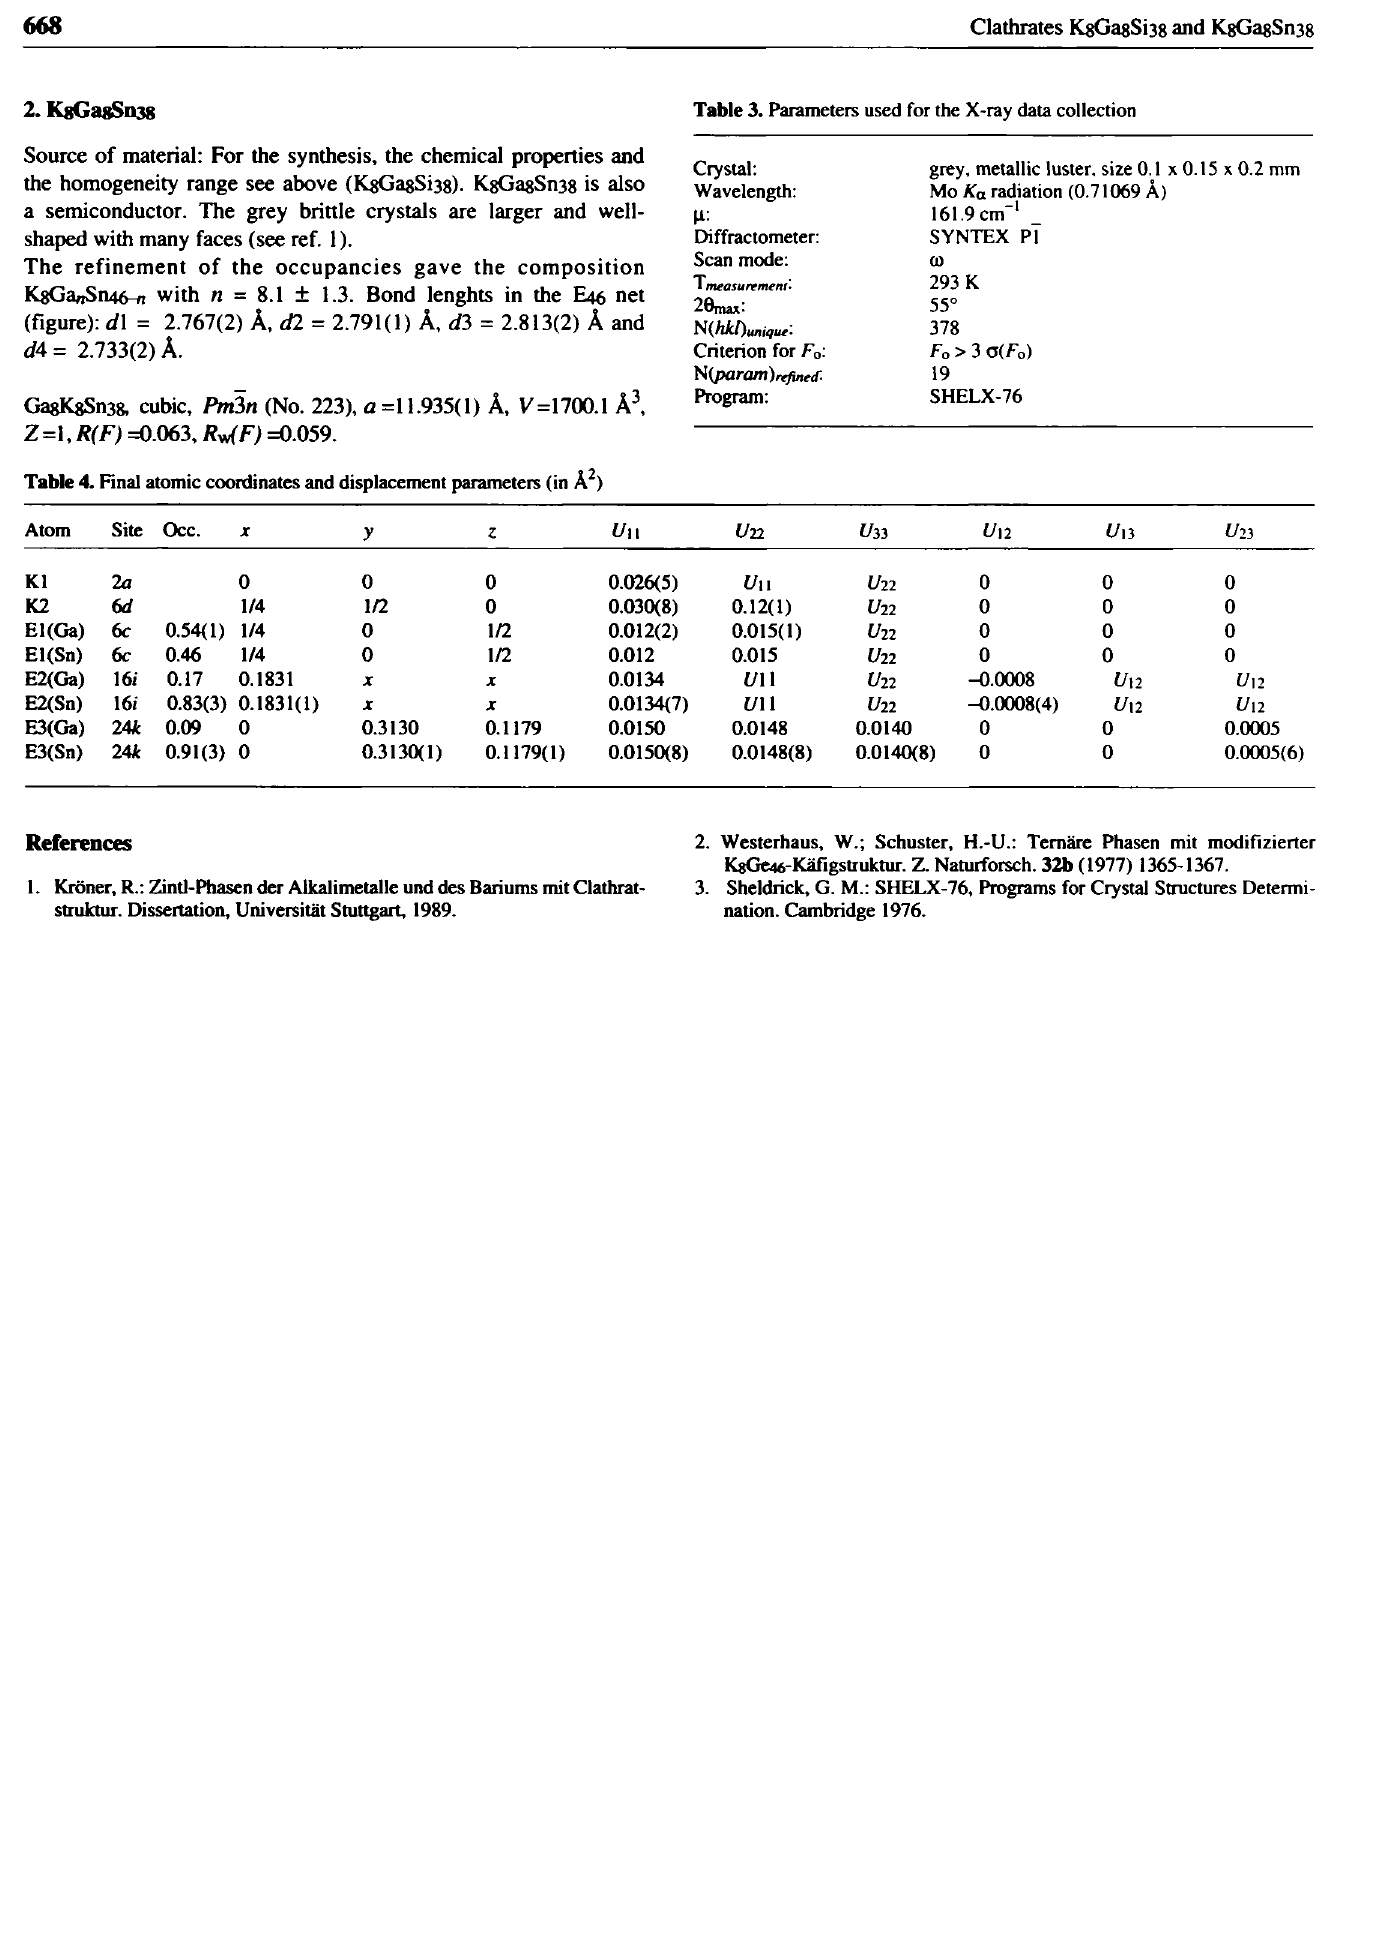
(figure): dl = 2.767(2) λ, d2 = 2.791(1) Â. d3 = 2.813(2) Â and d4 = 2.733(2) Â. Table 4. Final atomic ccwrdinates and displacement parameters (in A^)